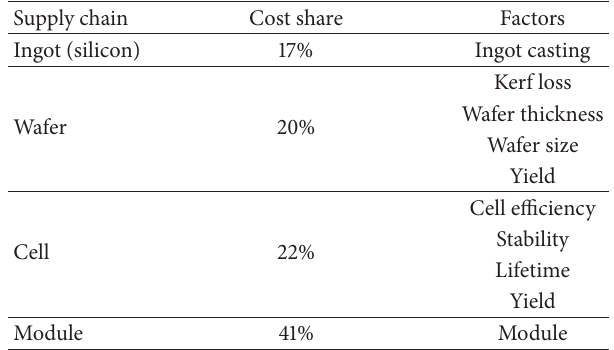
Table1:Productionchainwithcostsharesandtechnologyimprove- ment opportunity units for